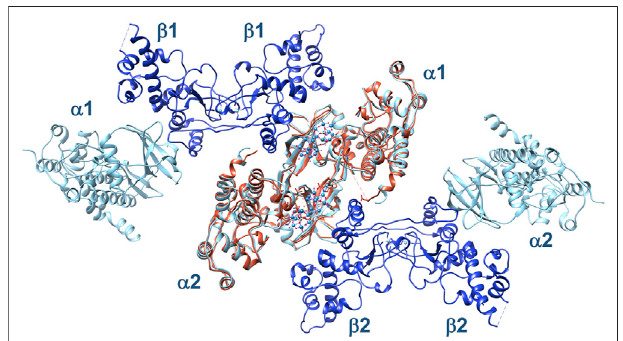
FIGURE 10 | Structural superposition of two α 2 β 2 tetramers, 1 and 2 ( α - subunits in cyan, β -subunits in blue), on the (CK2 α ) 2 (Ru 4 POM) 2 complex (in orange). In this arrangement, the two tetramers do not show evident steric clashes, suggesting that they can interact with Ru 4 POM in a similar way to the isolated catalytic